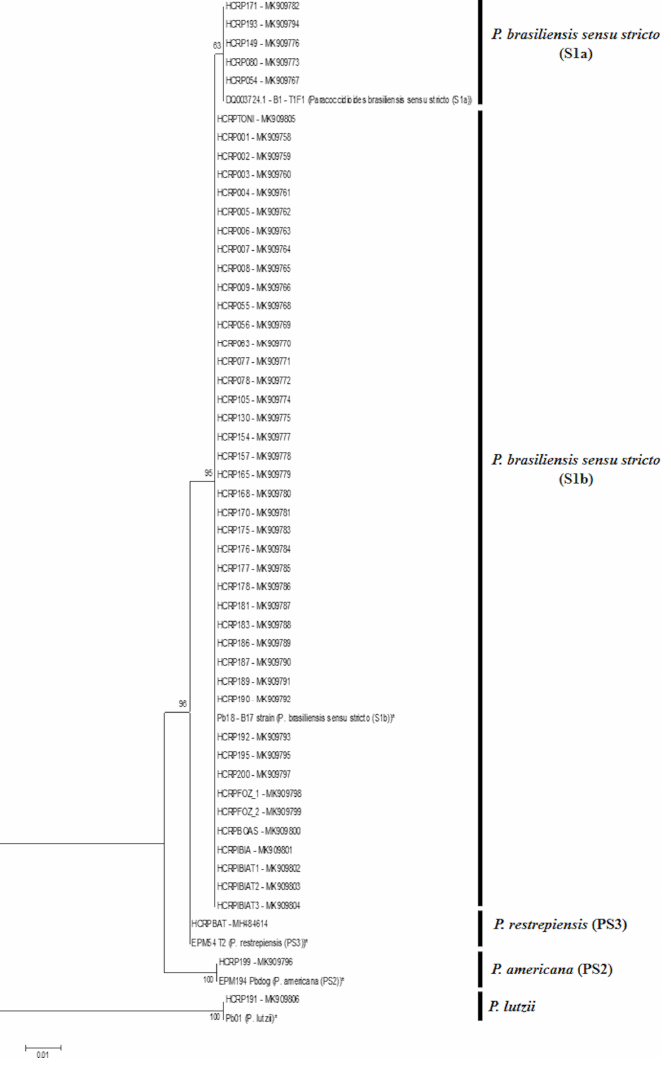
Figure 2. Phylogenetic analysis of gp43 exon 2 of clinical and environmental isolates of Paracoccidioides spp. compared to the reference strains (*), that were also sequenced for this study and had a 100% identity with the deposited sequences on GenBank under accession number: [Pb18—B17—DQ003729.1 ( P. brasiliensis sensu stricto (S1b); EPM194—Pbdog—DQ003736.1 ( P. americana (PS2); EPM54—T2—KT251008.1 ( P. restrepiensis (PS3); Pb01—EU870196.1 ( P. lutzii )]. Evolutionary history was measured by the maximum likelihood (ML) method based on the Kimura 2 model—parameter